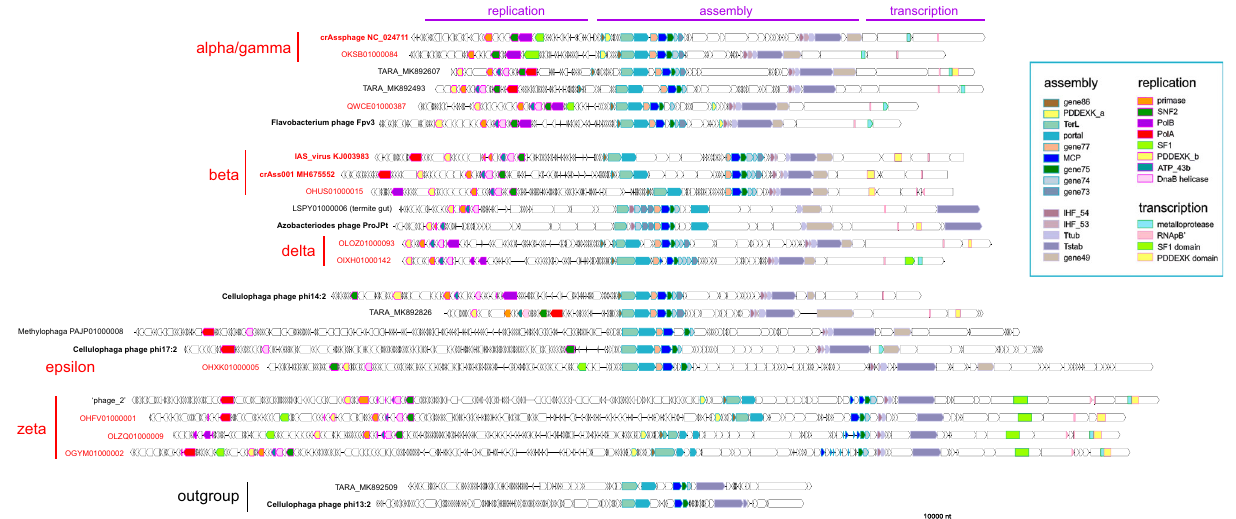
Fig. 2 Genome organizations of representative crAss-like phages. The circular genomes were linearized by breaking the circle after the transcription gene block. Conserved proteins are abbreviated as in Fig. 1c; RNApB ’ marks the conserved DxDxD motif of the large RNAP subunit homologous to the bacterial β ’